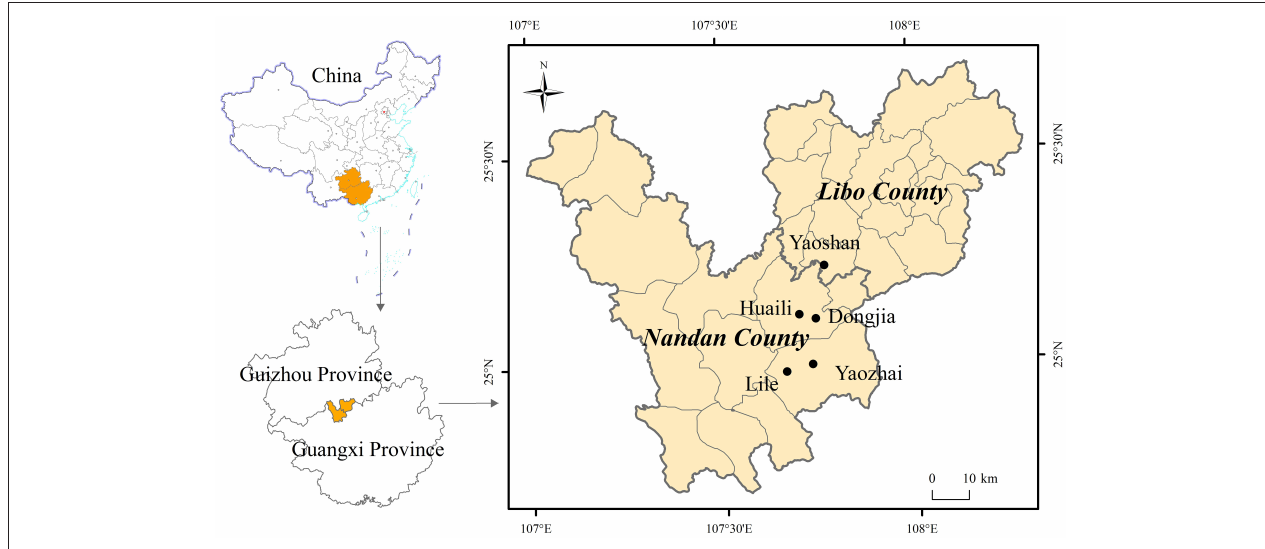
FIGURE 1 | The study area.